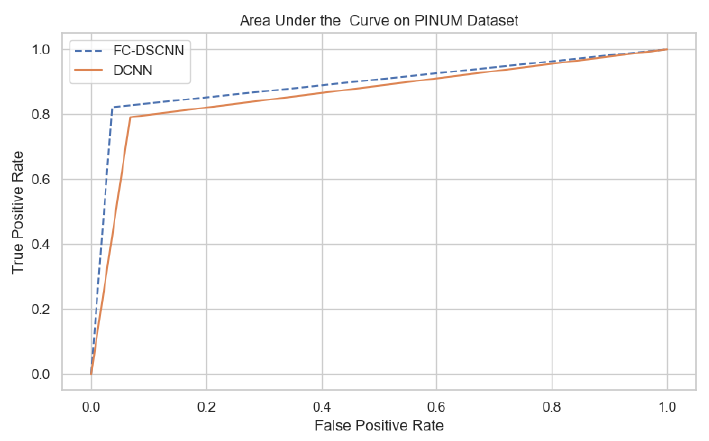
Figure 19. The AUC curve of the proposed method on the PINUM dataset is 0.87, which is higher than the DCNN, which is 0.80.